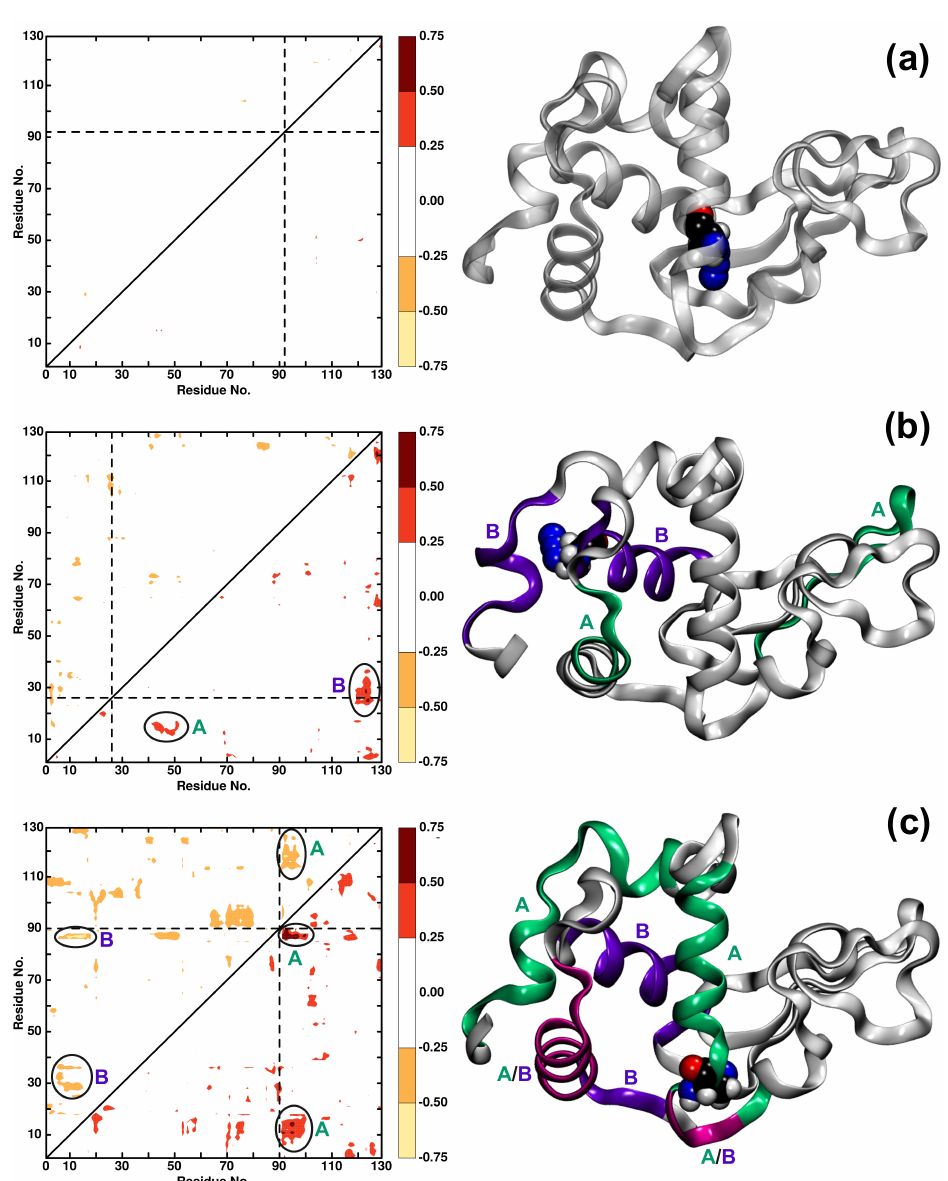
Figure 4. The difference in dynamic cross-correlation maps ( ∆ DCCM) between WT and ( a ) Ala92N 3 , ( b ) Ala26N 3 , and ( c ) Ala90N 3 . Positive differences are in the lower right triangle, negative differences in the upper left triangle. Only differences with an absolute value greater than 0.25 are displayed. The right panels show the protein structure with features A (green) and B (violet) and common residues between feature A and B (magenta) of ∆ DCCM plots highlighted in color. The AlaN 3 label is shown in